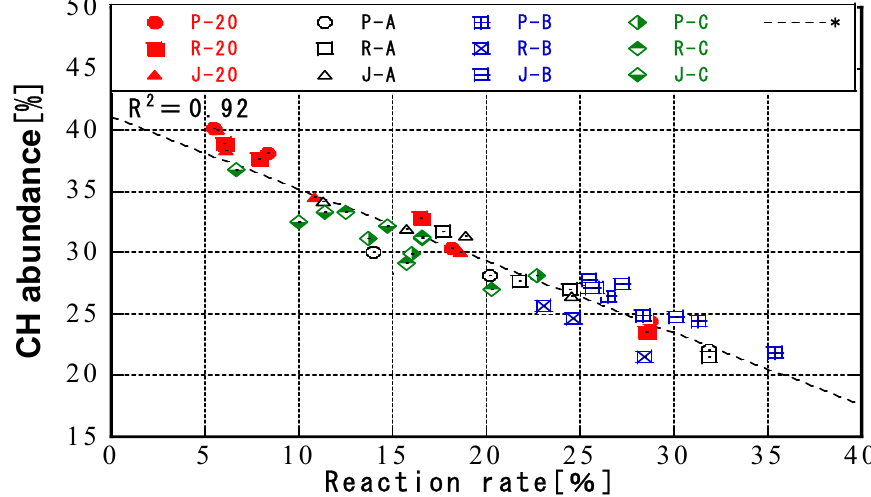
Figure 9. Relationship between FA reaction rate and CH abundance.